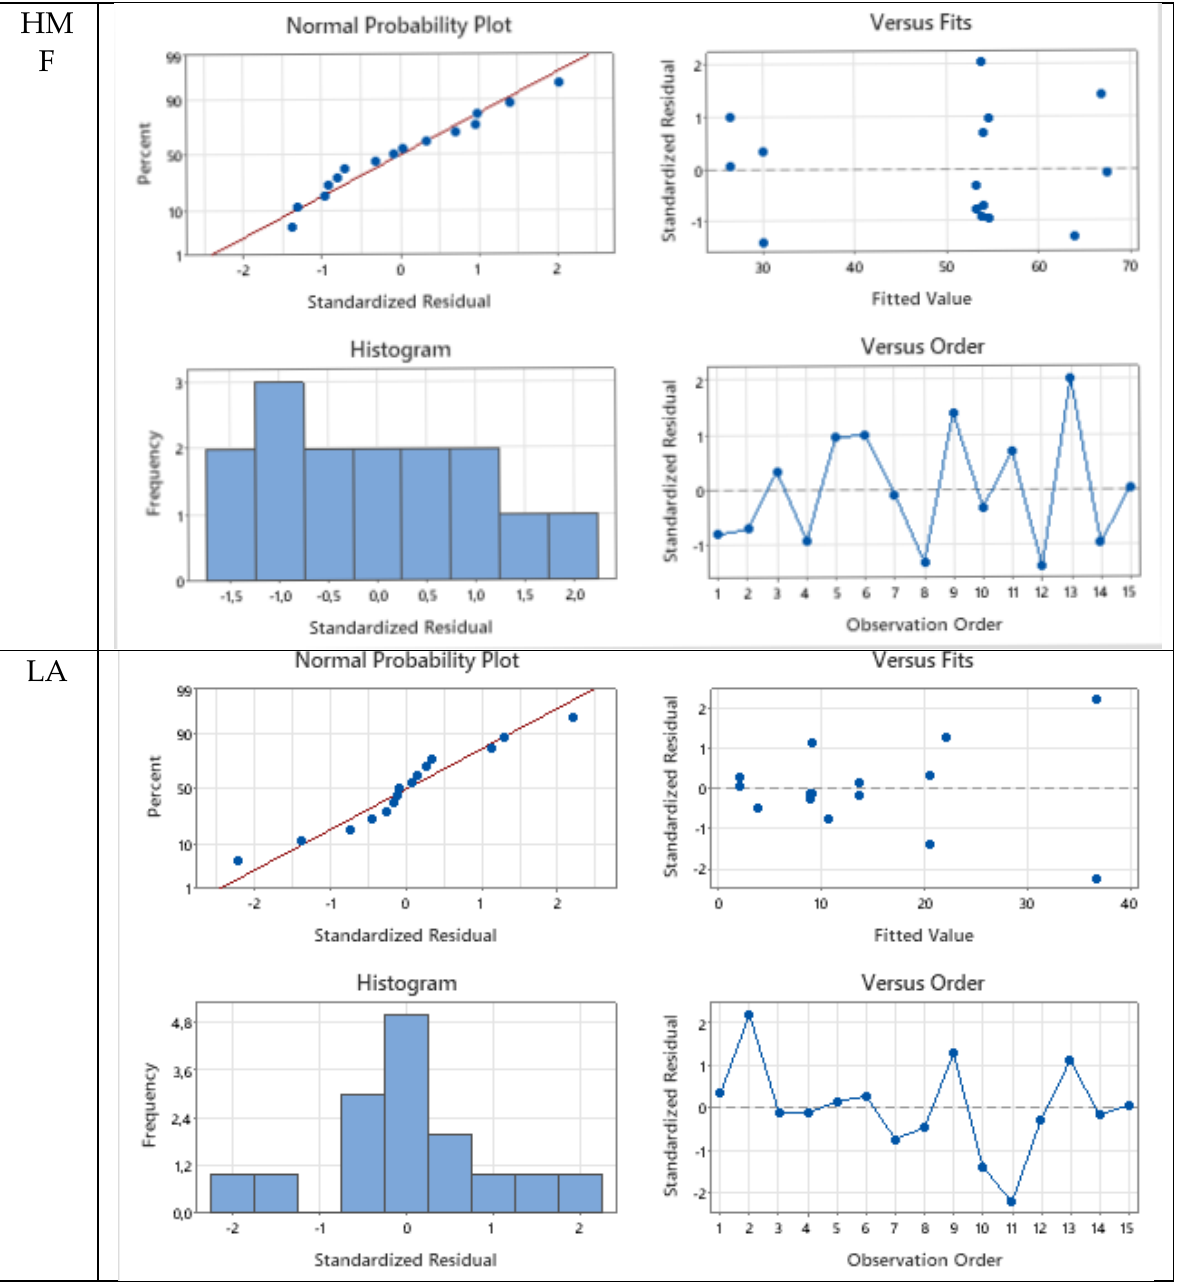
Figure 6. Balanced ANOVA diagrams prepared as general linear model fittings for the models obtained for FF, HMF, and LA during Cam: OA (1:1) extraction according to the RSM via the Box–Behnken design.